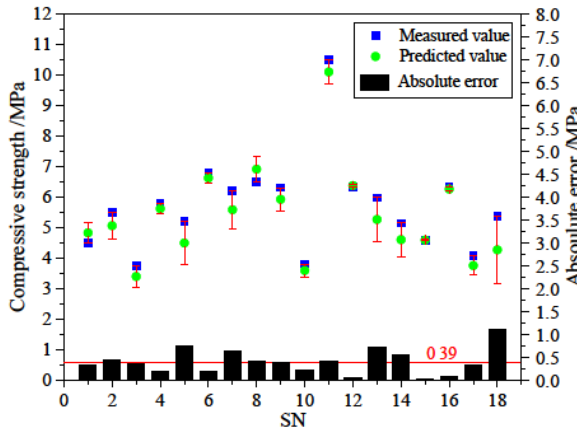
Figure 6: Schematic diagram of BP network topology was used as the output layer function, and the traingdm function in the BP algorithm was used as the training func- tion. The number of iterations, the learning rate, and the correction coefficient were set to 15,000 times, 0.05, and 0.10 respectively.